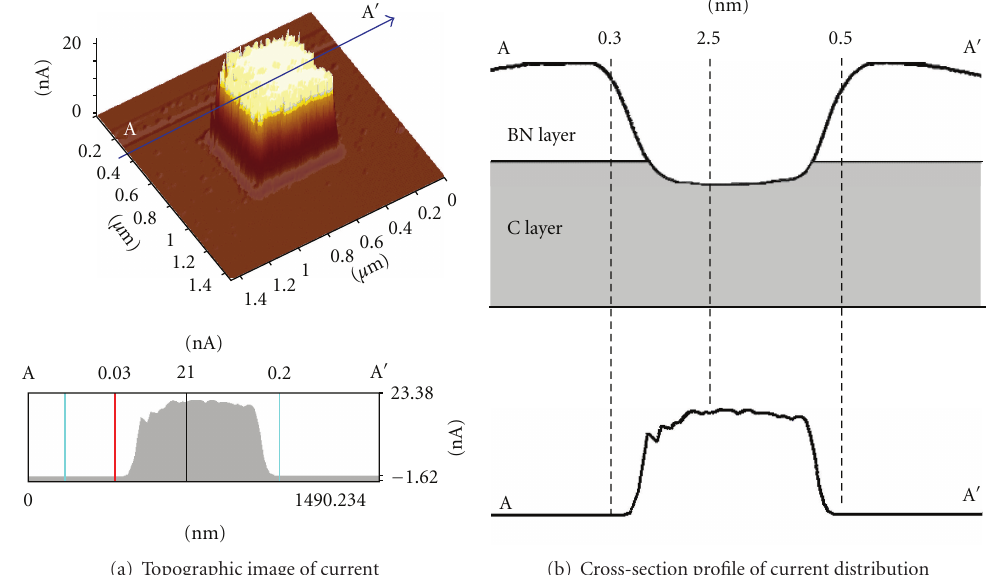
(b) Cross-section profile of current distribution Figure 17: (a) Profile and cross-sectional images of current distribution and (b) mode of current versus wear track for 4-nm-period (B/CN)n film at 1000 nN load and vibration amplitude of 20nm.